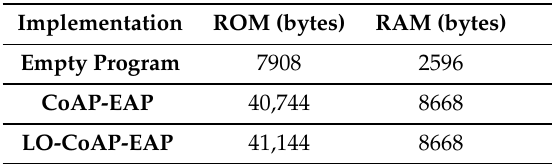
Table 9. Memory footprint of the implementations in